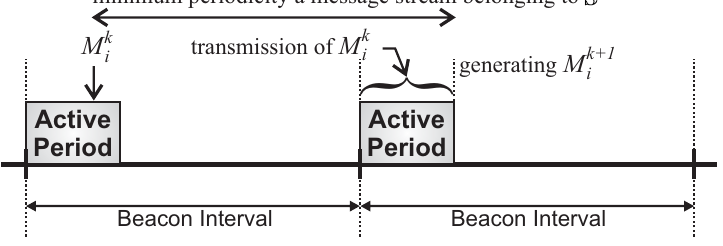
Figure 5. Length of beacon interval regarding message